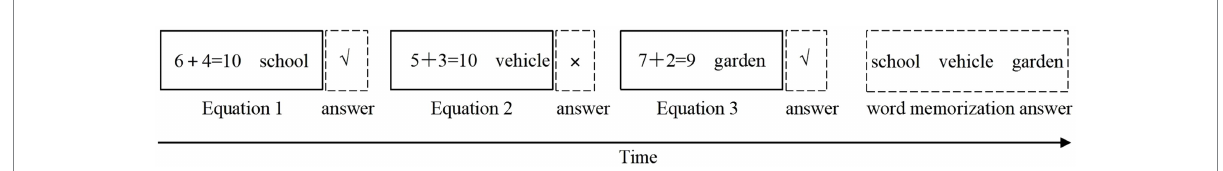
FIGURE 1 Example of a correctly solved Level 3 trial in the working memory test (translated from